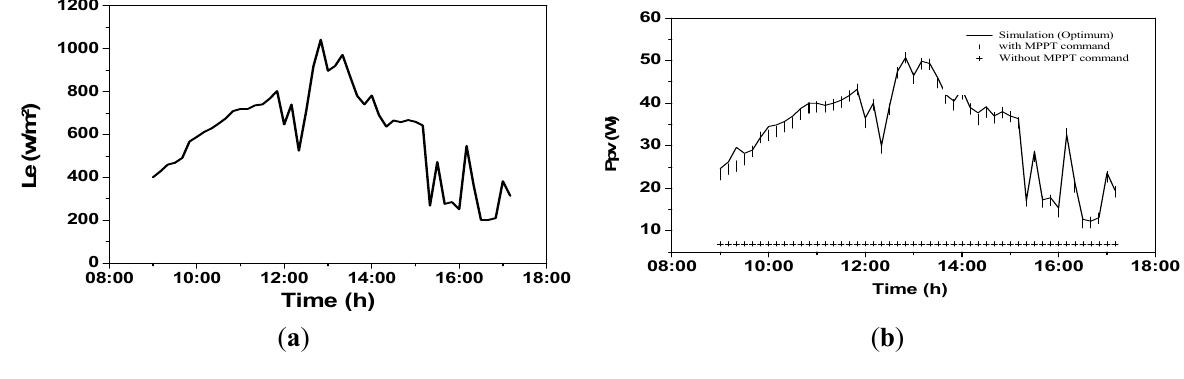
Figure 15. Illumination (Le) ( a ), power ( b ) of a PV panel (experimental and simulated (optimum)) and power losses ( c ) for a day, with and without Digital MPPT